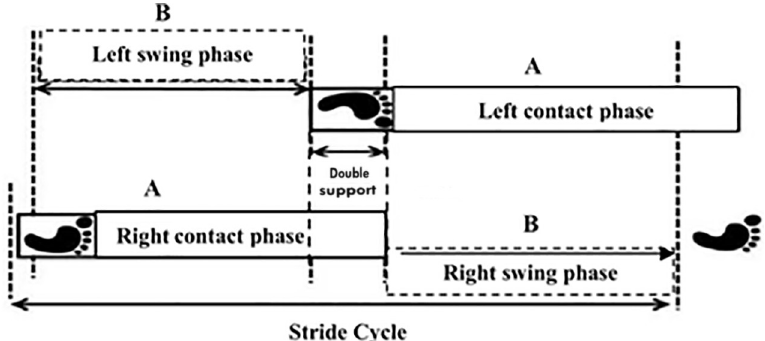
Fig 2. Definition of a stride cycle. The Contact Time (CT) is the time, during the stride cycle, in which the feet (right or left) is in contact with the ground (A). Swing phase time (ST) is the time, during stride cycle, in which the feet (right or left) is not in contact with the ground (B), adapted from Oliveira et al.